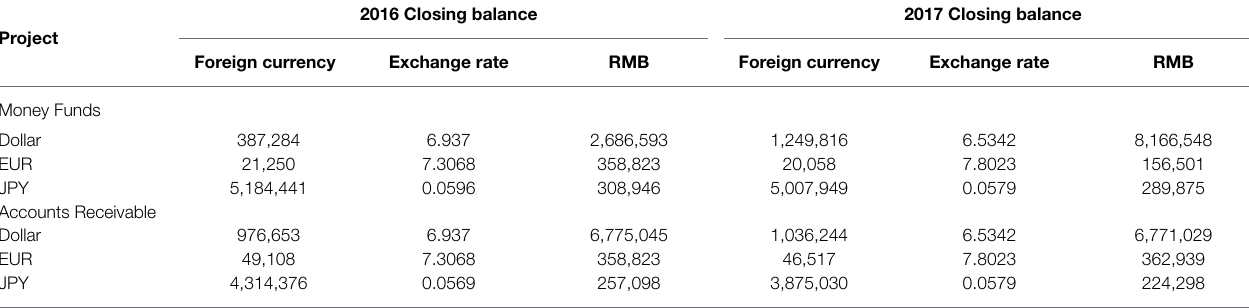
TABLE 9 | Haier’s foreign currency and monetary funds in 2016–2017.